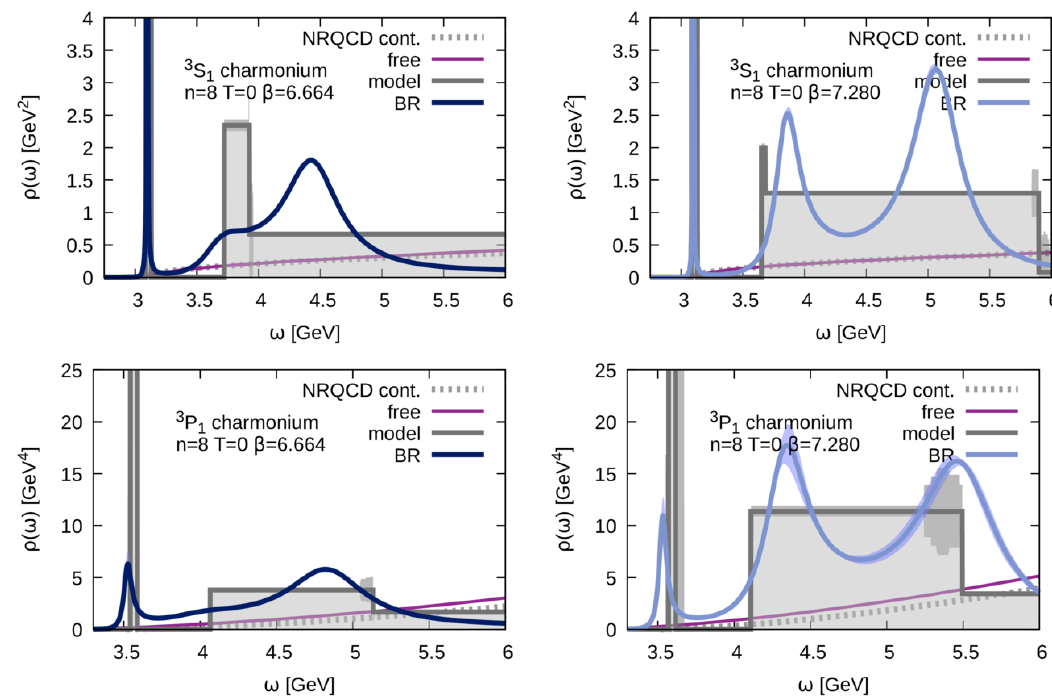
Figure 35 . Constrained model (cid:12)ts (gray) compared to the spectral reconstruction based on the standard BR method at T = 0.The top two panels show S-wave charmonium on the coarsest (cid:12) = 6 : 664 (left) and (cid:12)nest (cid:12) = 7 : 825 (right) lattices. The lower two panels on the other hand contain the results for P-wave charmonium again for both the coarsest (cid:12) = 6 : 664 (left) and (cid:12)nest (cid:12) = 7 : 825 (right)